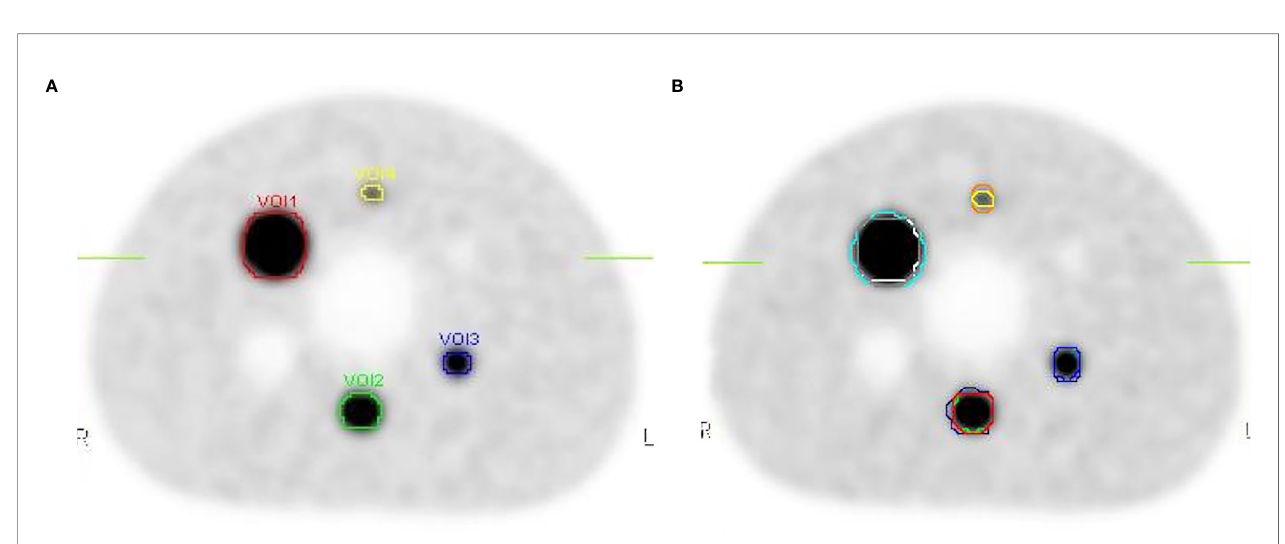
FIGURE 7 | The contours on the image show the delineations done by the threshold and the physicians. (A) The target volumes delineated based on the threshold. (B) The target volume contoured by three radiation oncologists.